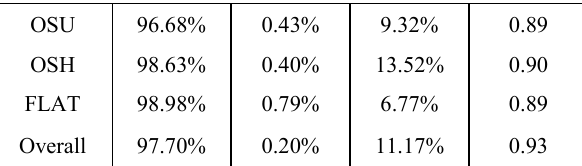
Table 4. The accuracy of snow cover by the dynamic threshold method.